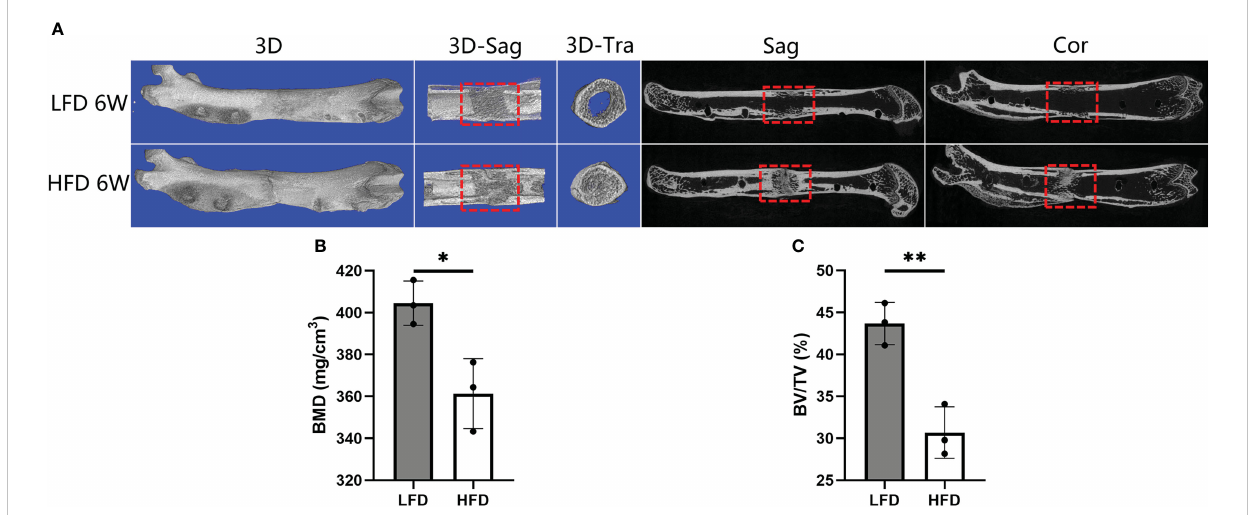
FIGURE 4 Results of micro-CT evaluation showing decreased regenerate quality after rats were fed a high-fat diet. (A) Representative three-dimensional (3D) micro-CT images of the distraction zone at the termination of the 6-week consolidation. (B, C) Quantitative evaluation of BMD and BV/TV, manifesting both two values in LFD group were signi fi cantly higher than those in HFD group. (*P<0.05,